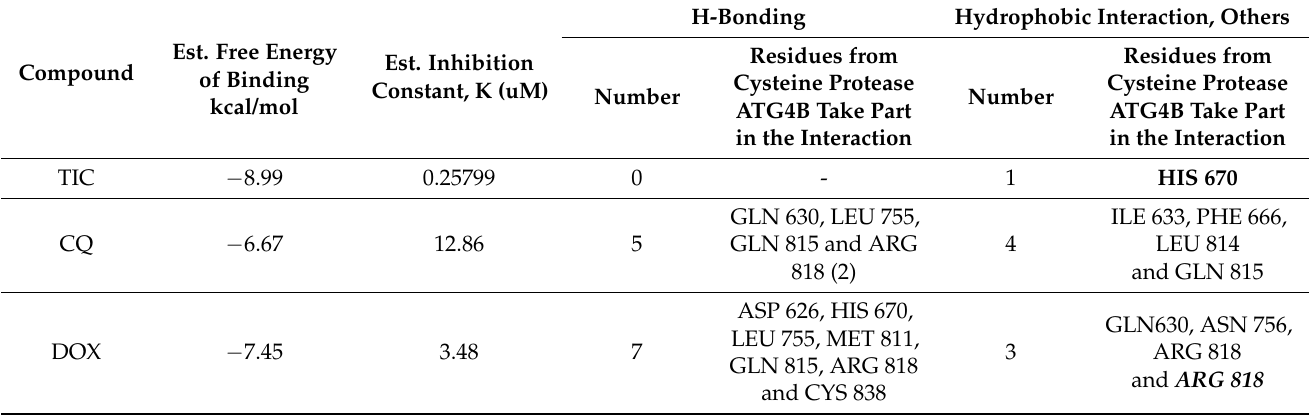
Figure 1. The predicted conformation docking of doxorubicin (DOX), Chloroquine (CQ), and tioconazole (TIC) in complex with ATG4B, PI3K α isoform and, PI3K γ isoform. The binding models obtained from the docking simulation analysis of TIC ( A ), CQ ( B ), DOX ( C ) selected drugs against ATG4B (PDB 2Z0D) ( I ), PI3K α (p110alpha/p85) catalytic subunit (PDB 2RD0) ( II ) and PI3K γ kinase (PDB 1E8X) ( III ). The ligands (drugs) are represented as an orange stick, and the active site residues in the expanded panels are represented in blue sticks while interacting residues are in lines and labeled with their three-letter code. Structures of all proteins are shown as cyan-colored ribbon surface model, and H-bonds and hydrophobic interactions are shown by a blue line and dashed-gray line, respectively. Table 2. Results of the docking of FDA-approved drugs and the interactions constructed on the crystal structure of PI3K α (PDB ID: